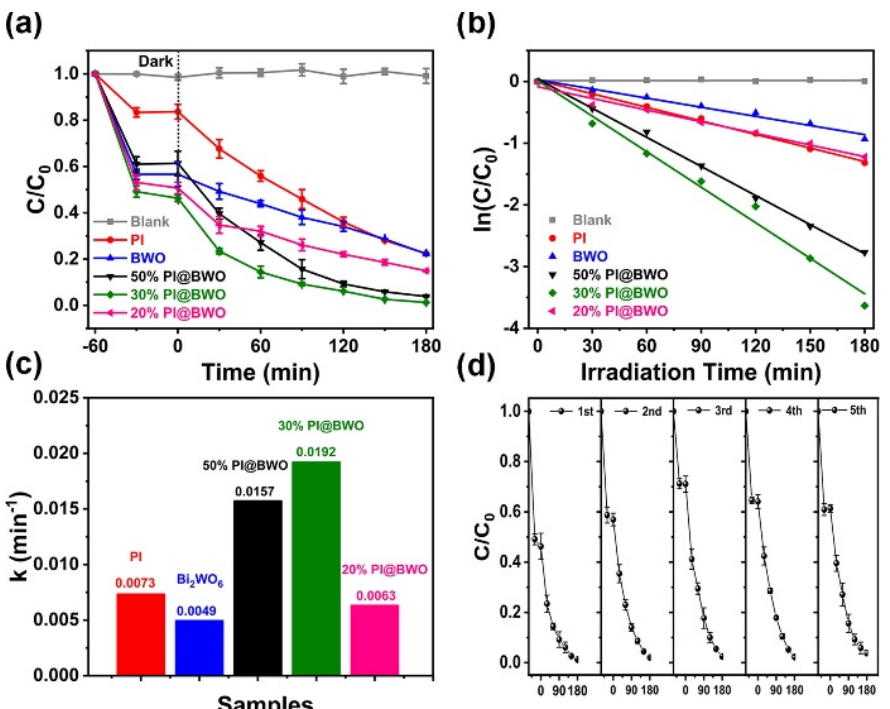
Figure 12. ( a ) BPA photocatalytic removal performance over as-prepared samples under visible light illumination, ( b ) pseudo-first-order kinetics equation fitted with the BPA degradation processes over different samples, ( c ) kinetic rate constants (min − 1 ) of the samples, ( d ) five consecutive photocatalytic degradation cycles over 30% PI@BWO [161].